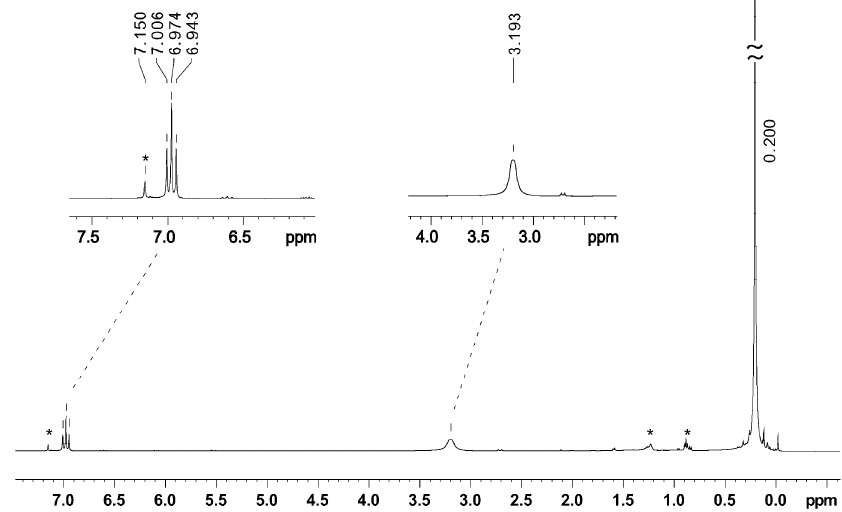
Figure 1. 1 H NMR spectrum (500 Mhz) of isolated 1 , recorded in C 6 D 6 . The starred peaks represent impurities: δ 7.15 (residual protons of C 6 D 6 ); δ 0.9 and δ 1.3, residual hexanes. Table 2. 1 H NMR shifts (ppm) and bond distances in M[M’A’ 3 ] complexes.